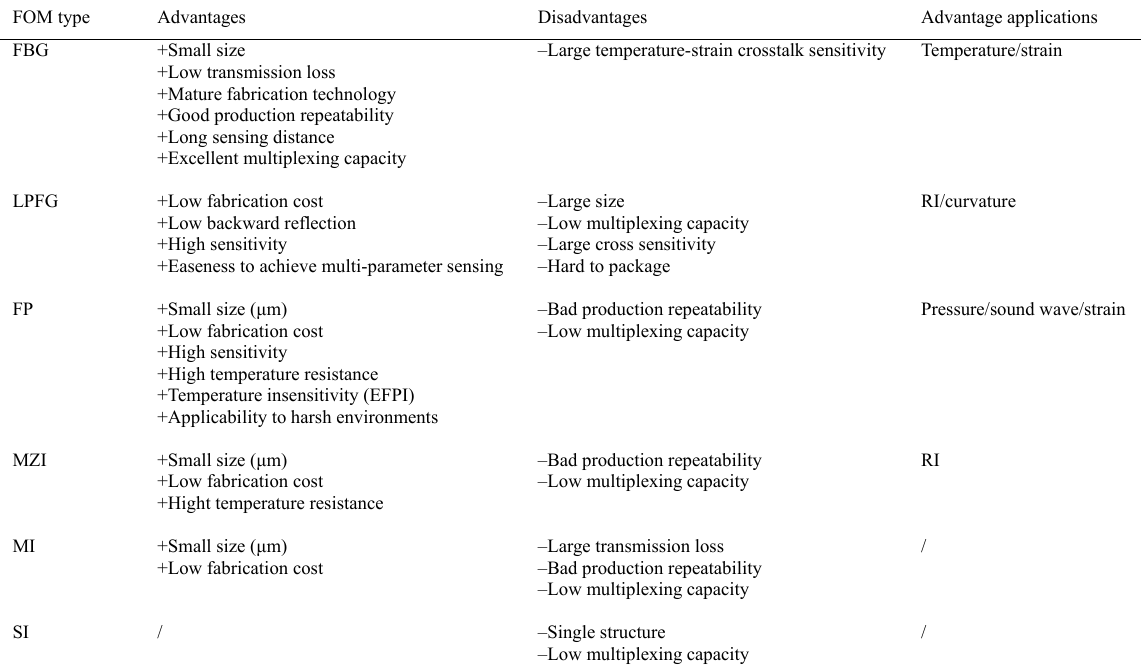
Table 9 Performance comparison of different types of FOM